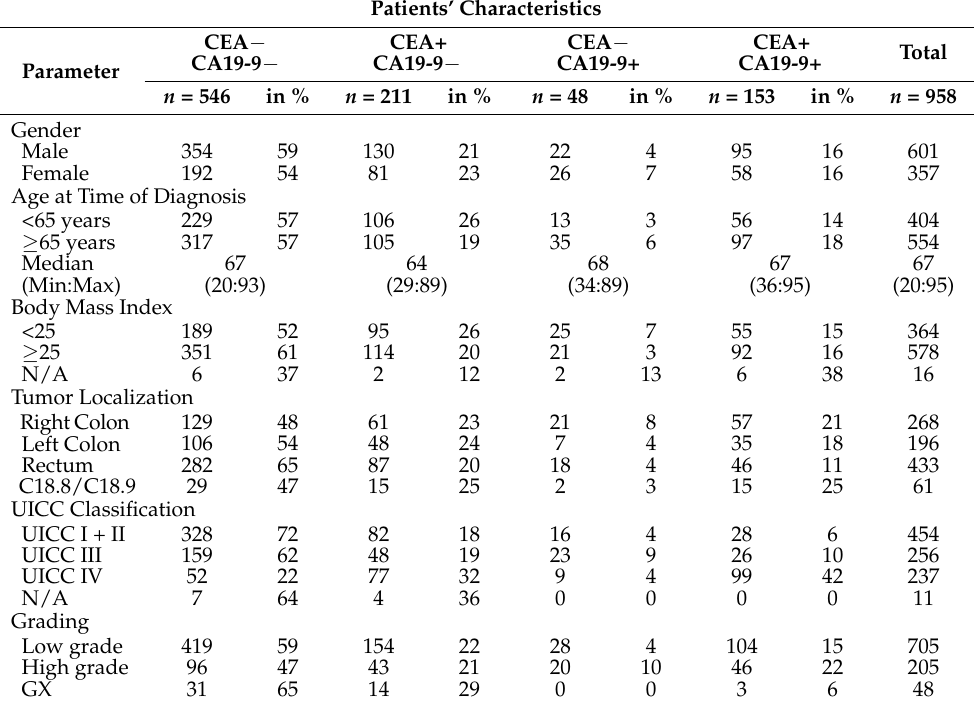
Table 1. Patients’